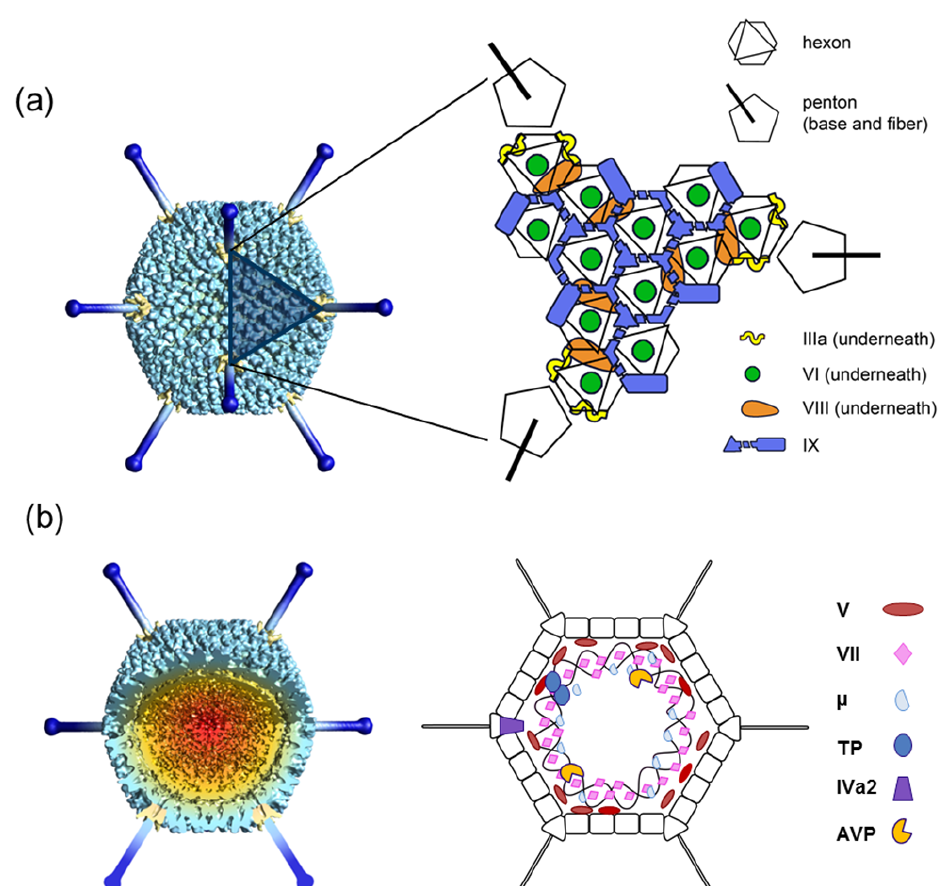
Figure 1. Overall AdV structure and components. (a ) Icosahedral shell organization according to current structural knowledge. The left hand side panel is a model built from a low resolution cryoEM map, with penton bases highlighted in yellow, and fibers built from the crystal structure of the knob and distal shaft [27] in dark blue. The shaded triangle indicates one facet. ( b ) Non-icosahedral components. A segment has been removed from the cryoEM map to show the inner capsid contents. The schematics on the right hand side indicate tentative positions, as little is known about the structure and organization in the virion of the genome and accompanying proteins. Polypeptide IVa2, which binds to the specific packaging sequence in the viral genome, has been reported to occupy a singular vertex in the capsid